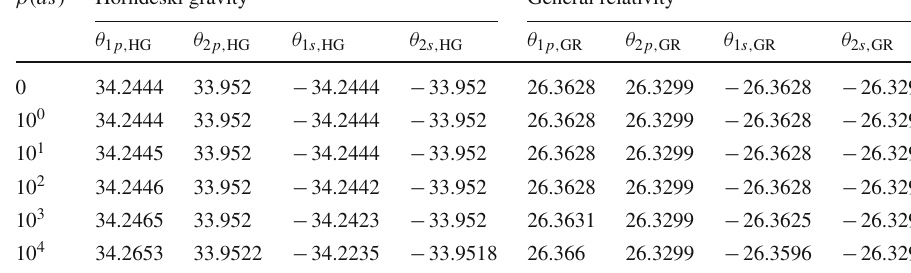
Table 5 Image positions of first and second order primary and secondary images due to lensing by M87* with d = D LS / D OS = 0 . 5: GR and Horndeski Gravity ( q = − 0 . 5 ) predictions for angular positions θ of primary ( p ) and secondary images ( s ) are given for different values of angular source position β . (a) All values of